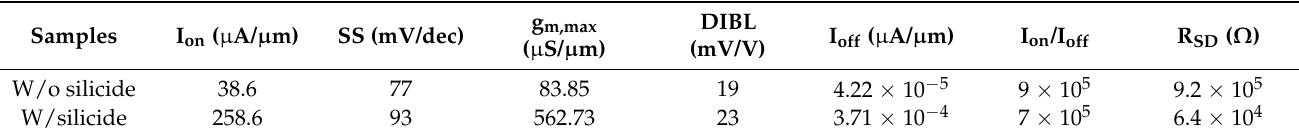
Table 1. The comparison of electrical characteristic parameters for the 4-levels vertically stacked Si 0.7 Ge 0.3 NWs GAA devices with or without S/D silicide